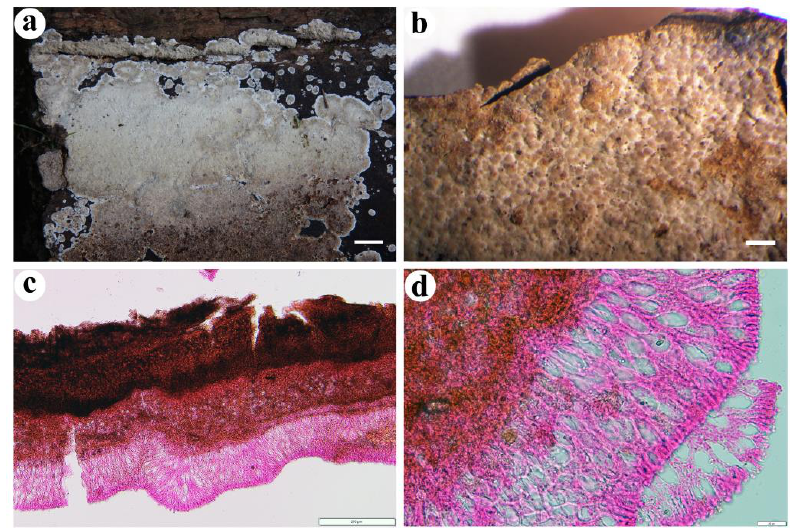
Figure 7. Cystostereum submurrayi (from the holotype BJFC 020755). Scale bars: ( a ) = 1 cm; ( b ) = 1 mm; ( c ) = 200 µm; ( d ) = 20 µm. ( a , b ). Basidiomes; ( c ). Part of a vertical section through basidiome; ( d ). Close-up of a vertical section through basidiome.